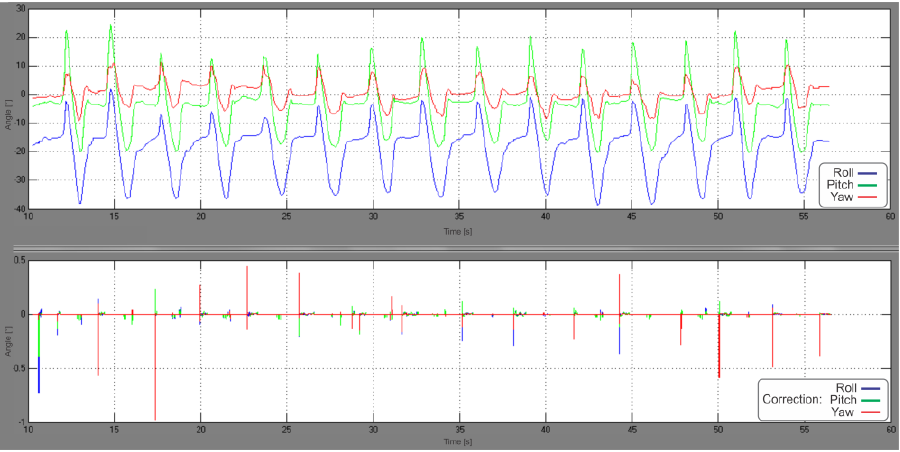
Figure 10. IMU frame orientation during the slow walking experiment, converted to Euler angles ( above ). Rotational corrections, made by the complementary UKF, converted to Euler angles ( below ).